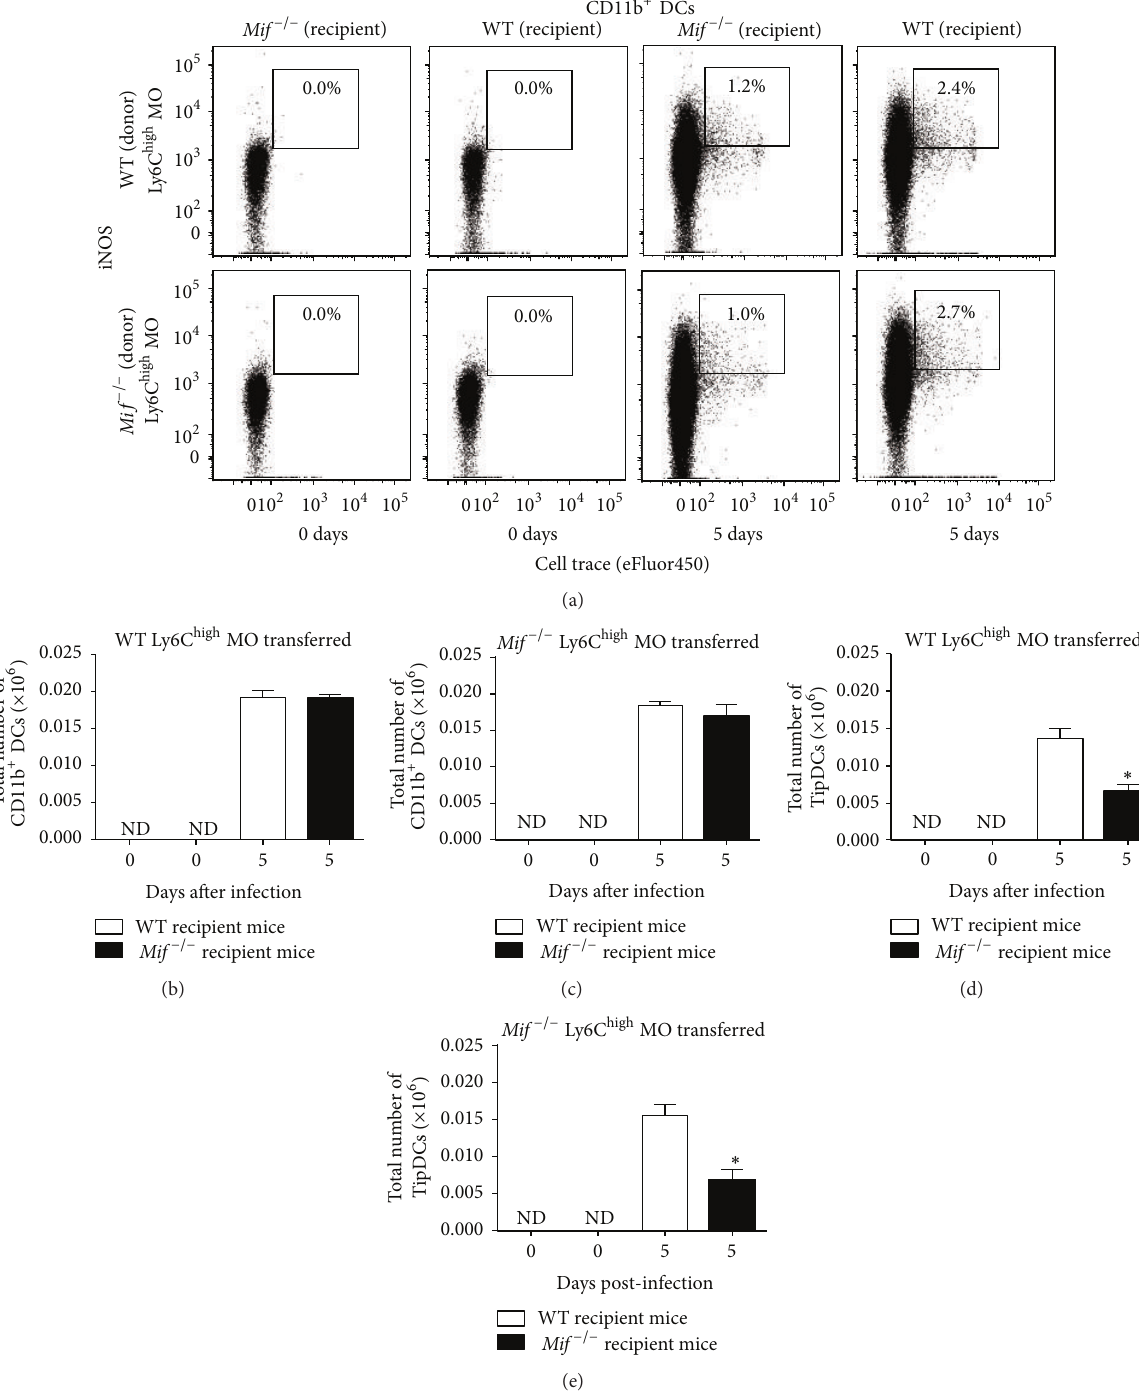
Figure 7: MIF promotes conversion of adoptively transferred Ly 6 C high monocytes into TipDCs during acute T. gondii infection. Isolated WT or Mif −/− Ly 6 C high monocyteswereadoptivelytransferredintorecipient T.gondii -infectedWTor Mif −/− miceandanalyzedforCD11b + TipDC markers at 0 and 5 days after infection in the peritoneal cavity. (a) Representative dot plots from adoptively transferred WT or Mif −/− Ly 6 C high monocytes differentiated into TipDCs. (b) Absolute numbers of adoptively transferred (cell trace-eFluor 450 + cells) WT Ly 6 C high or (c) Mif −/− Ly 6 C high monocytes differentiated into CD11b + DCs (CD11c + MHCII + CD11b + ). (d) Absolute numbers of adoptively transferred WT Ly 6 C high or (e) Mif −/− Ly 6 C high monocytes differentiated into TipDCs (CD11c + MHCII + CD11b + iNOS + ). Data are representative of 2 independent experiments and are represented as the mean ± SE. ∗ 𝑃 < 0.05 ; ∗∗ 𝑃 < 0.01 . ND: not